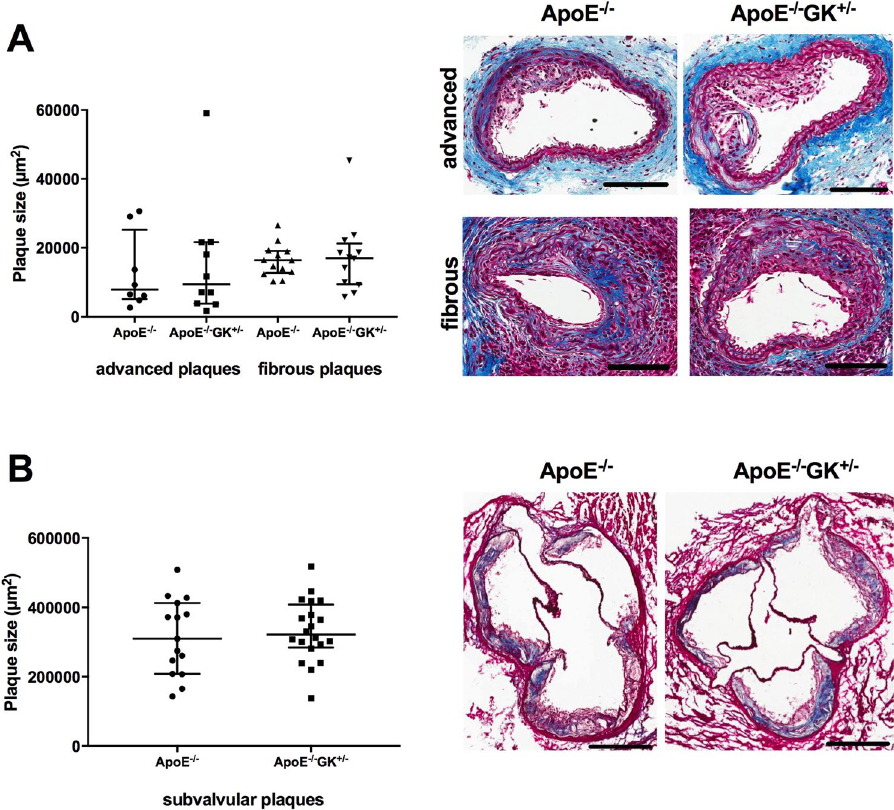
Figure 3. Hyperglycemia does not affect the plaque size. Overview of the induced lesions in the carotid artery showing no difference in advanced or fibrous plaque size between the ApoE − / − GK + / − and ApoE − / − mice ( A ). Visualized by Masson’s Trichrome stain. Scale bars = 100 µ m. ( B ) Subvalvular plaques from aortic root sections stained with Masson’s Trichrome showing similar plaque size between the ApoE − / − GK + / − and ApoE − / − mice. Scale bars = 400 µ